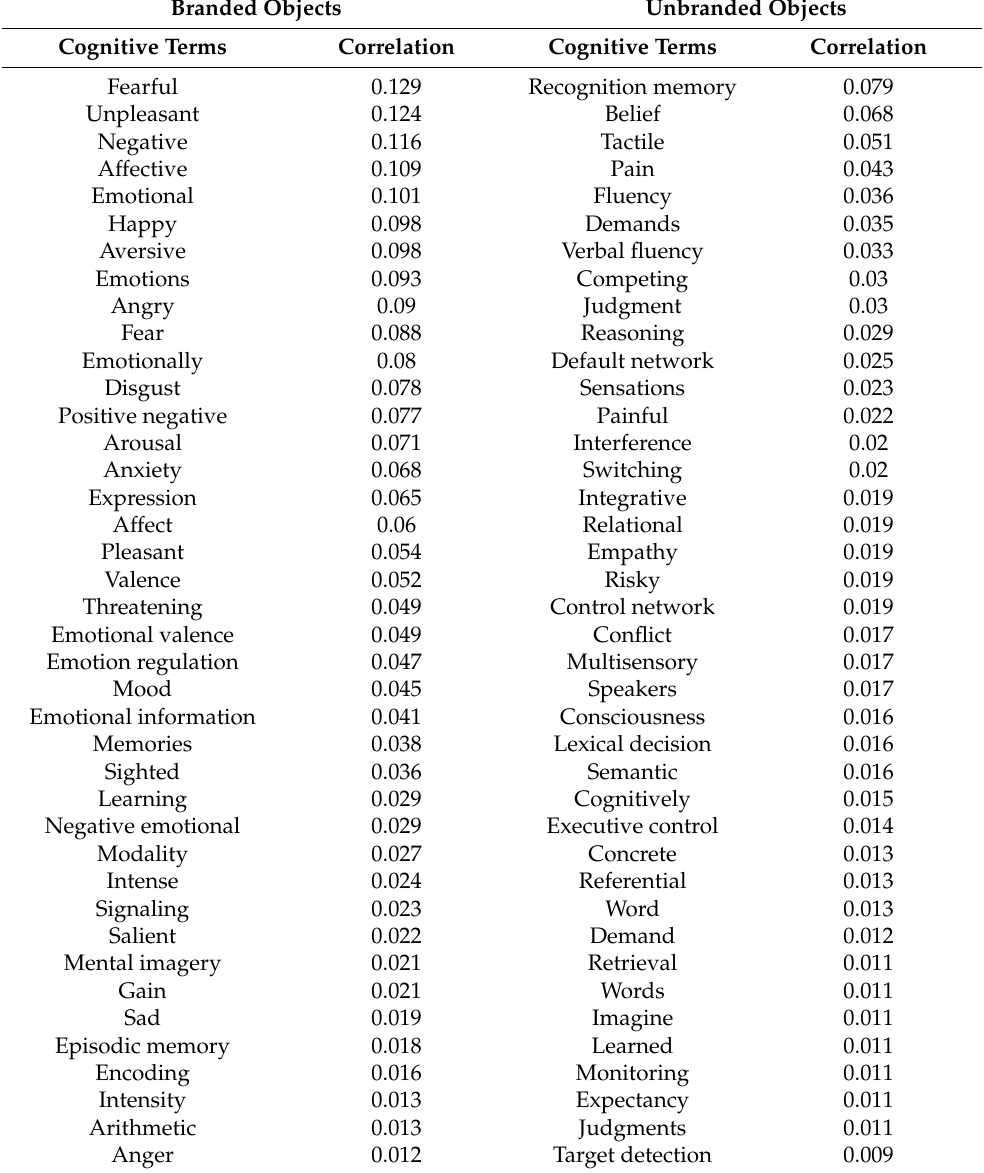
Table 8. Results of decoding study by Neurosynth. Each term was sorted by higher correlation values